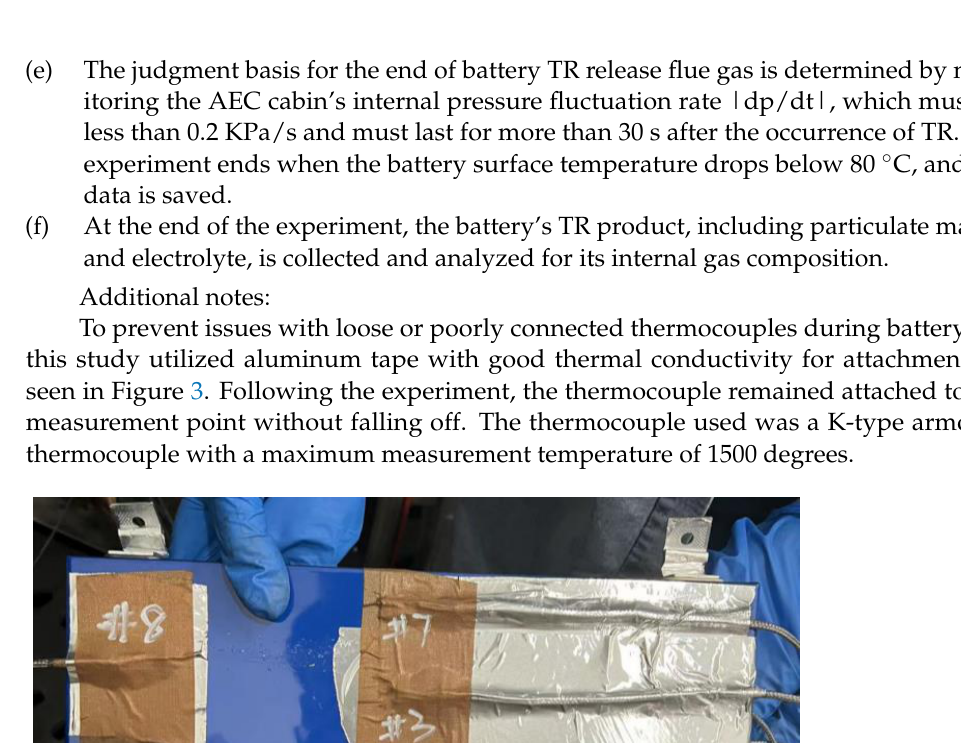
Figure 3 . Thermocouple paste method diagram. Figure 3. Thermocouple paste method